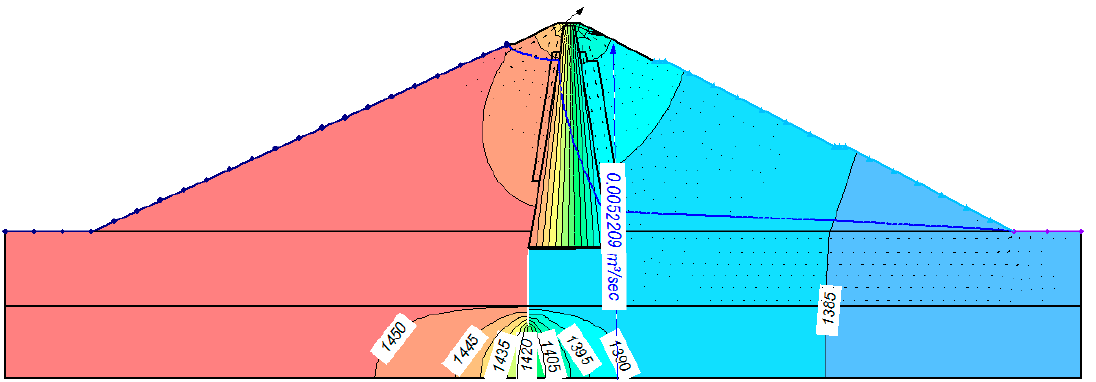
Figure 10. Equipotential lines and discharge counters of the dam with a grout curtain of 30 m long.